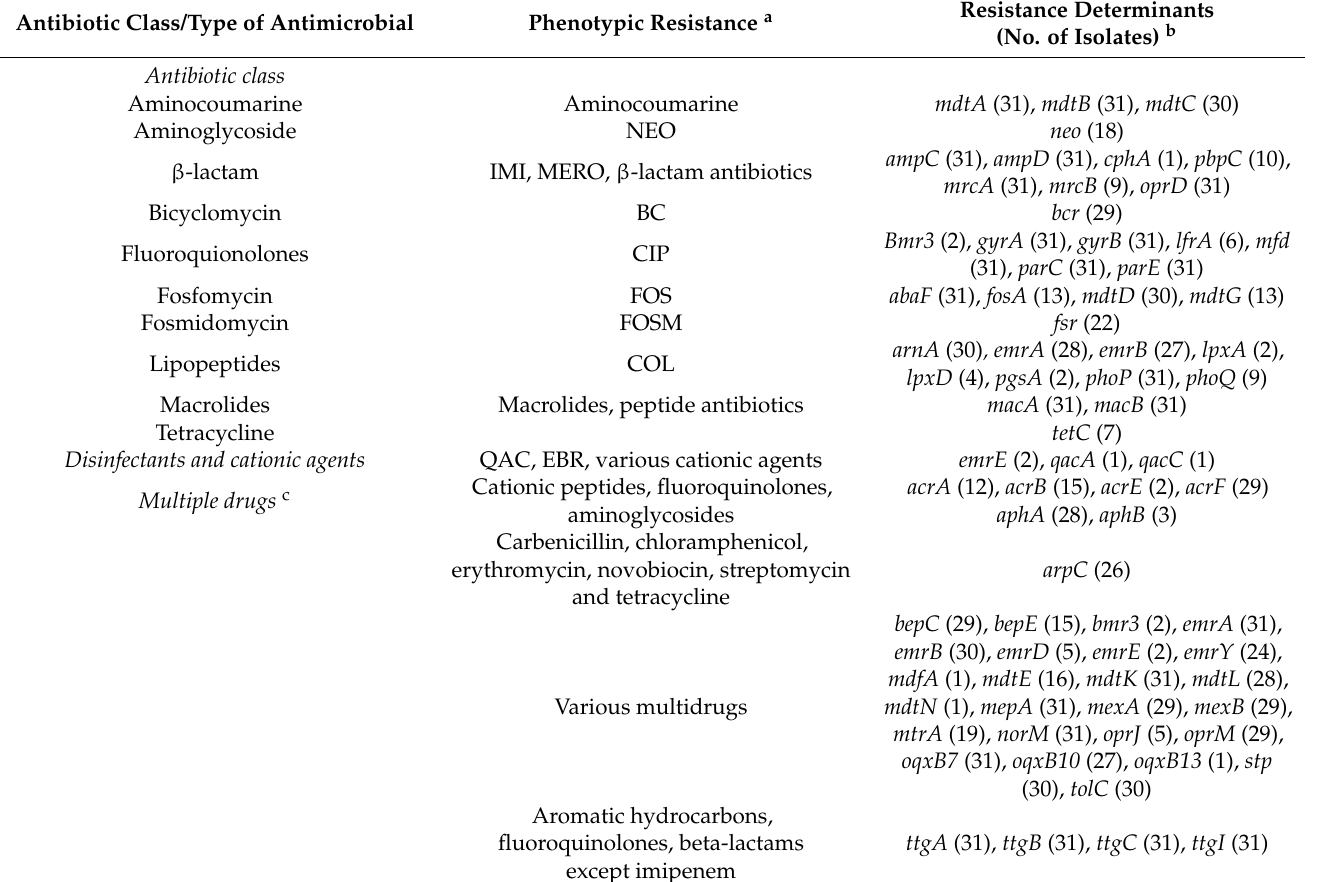
Table 4. Resistance determinants in Pseudomonas spp. (n =